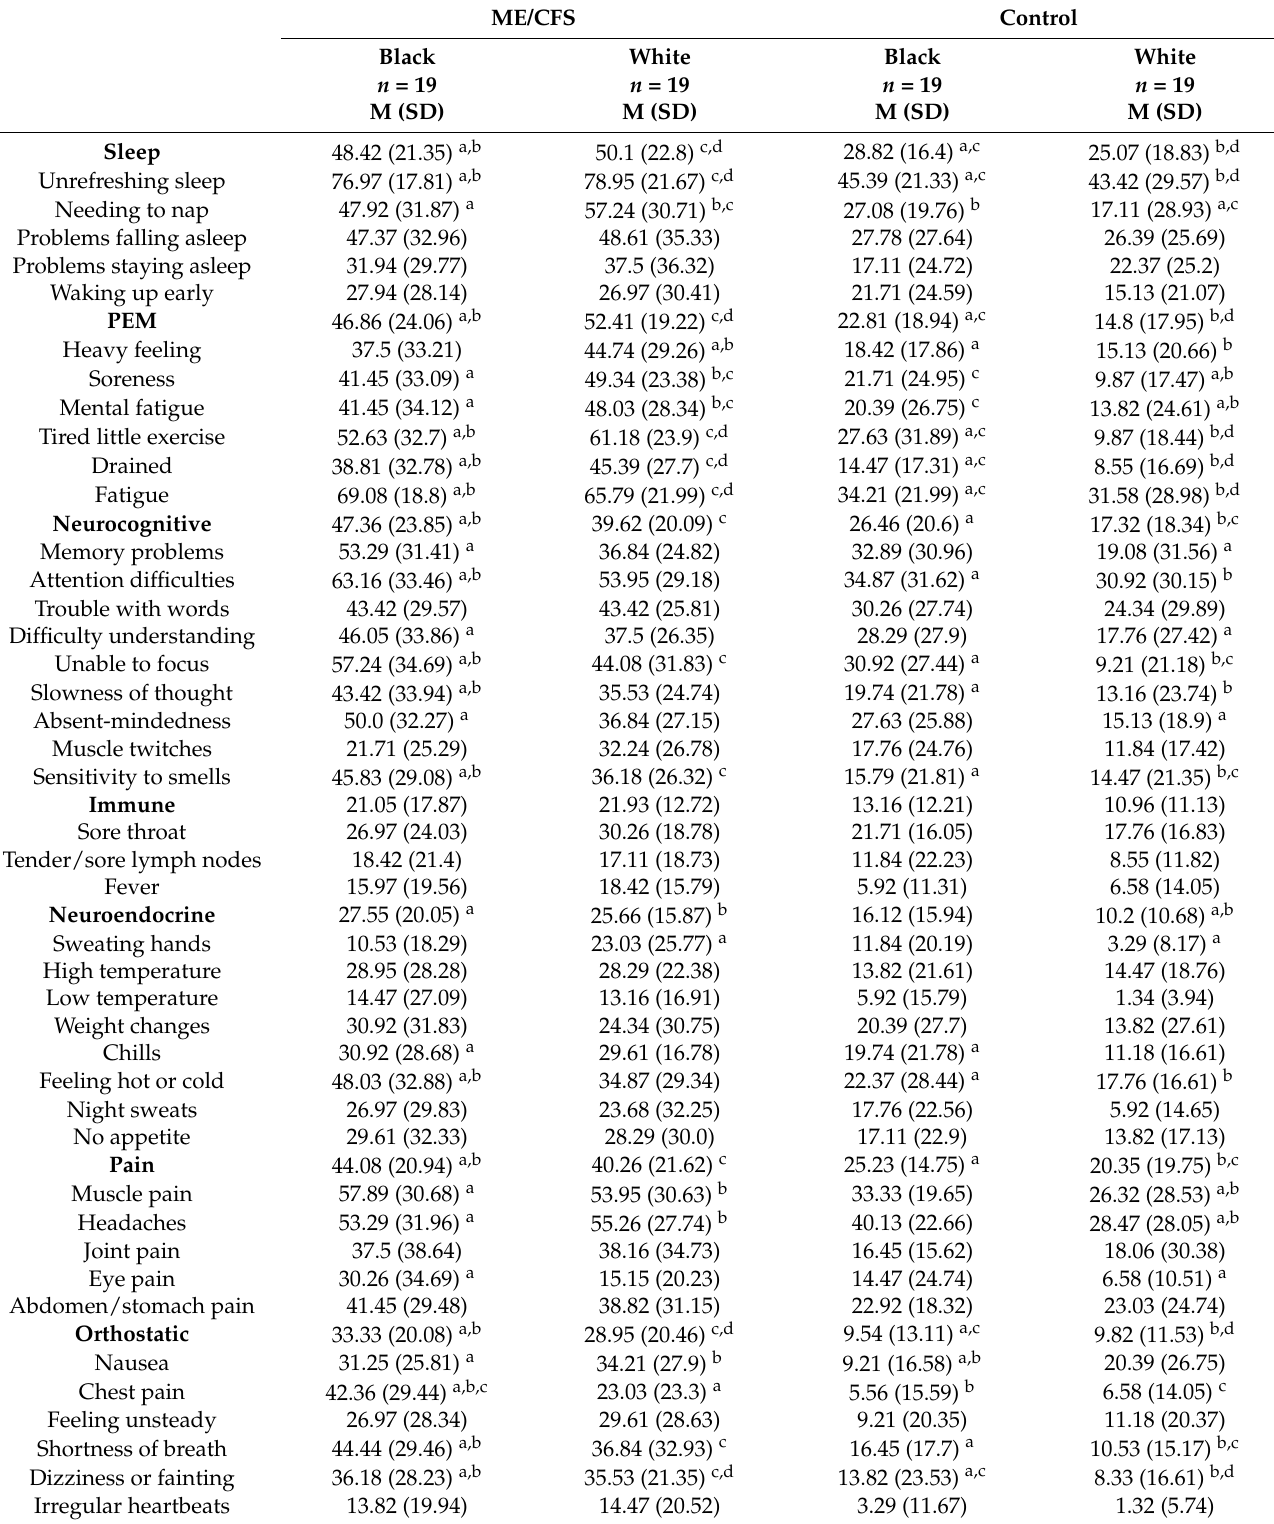
Table 1. ME/CFS versus controls; White versus